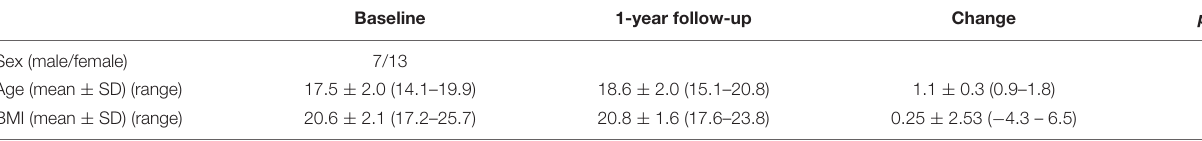
TABLE 1 | Demographics. Baseline 1-year follow-up Change p value